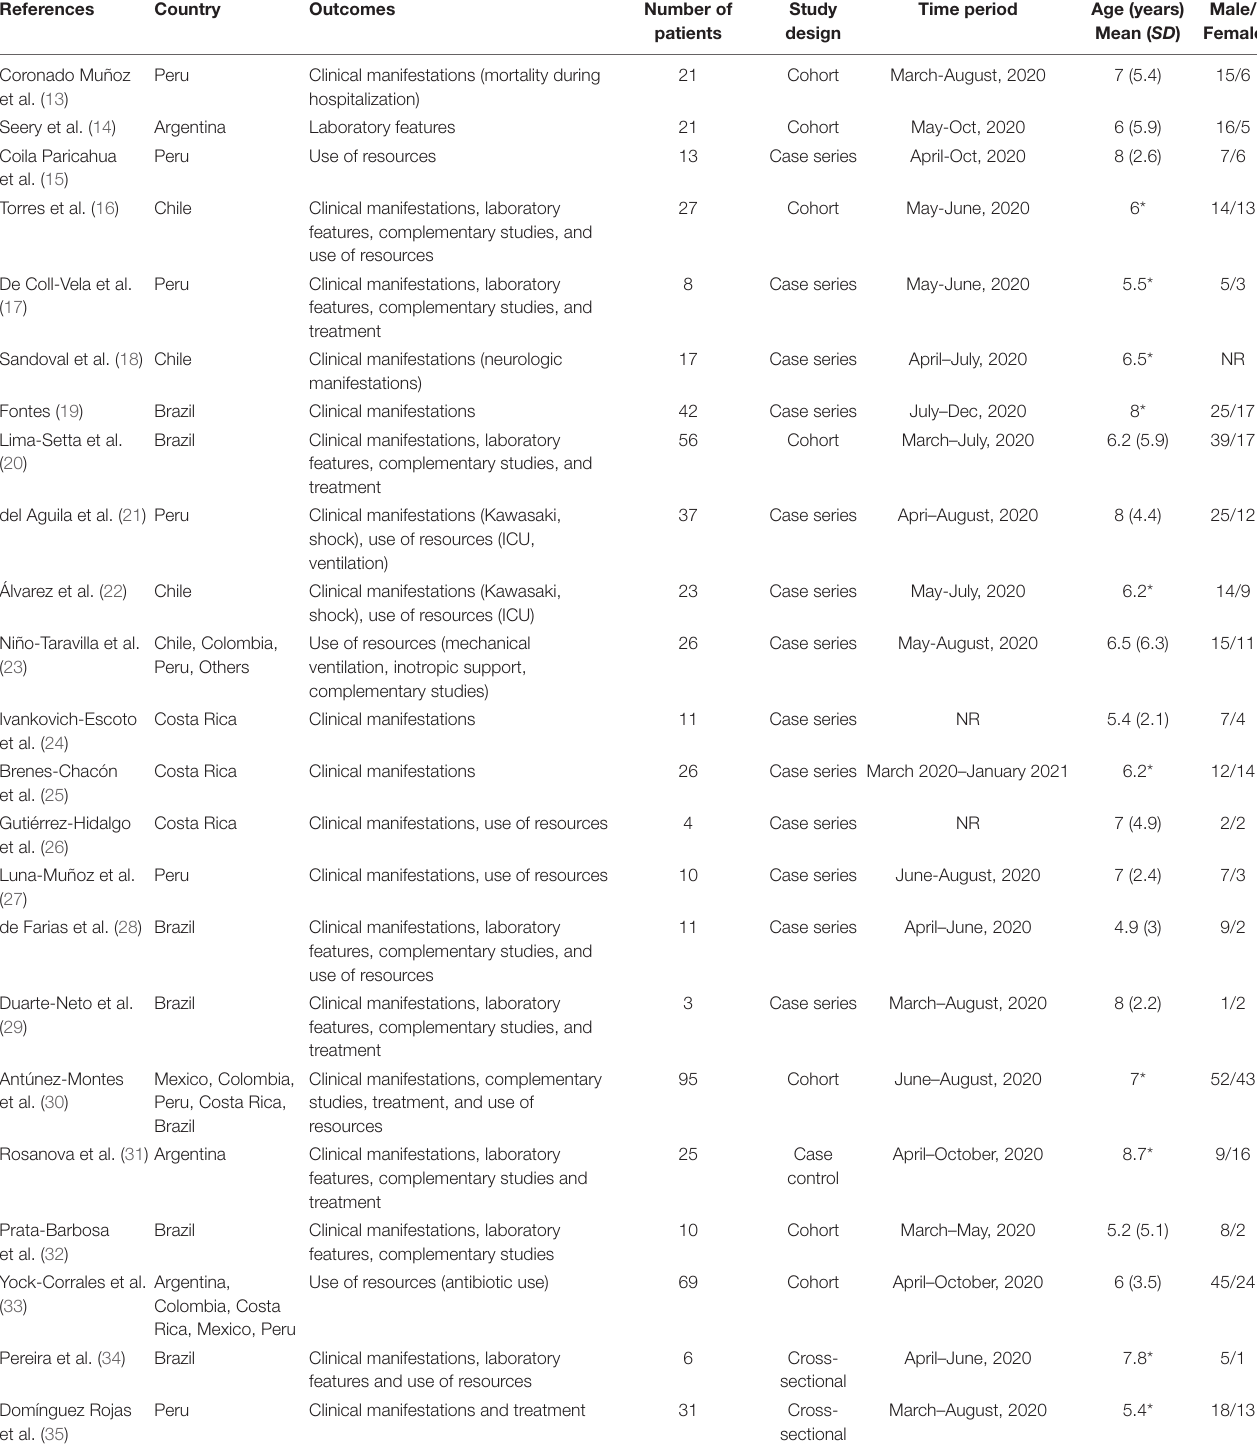
TABLE 1 | Characteristics of the clinical studies of MIS-C identified in Latin America and the Caribbean ( N =